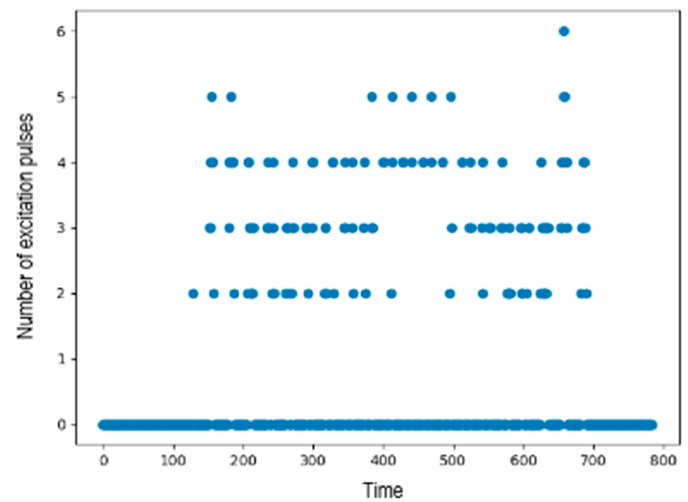
Figure 3. Diagram of Excitation Pulse.